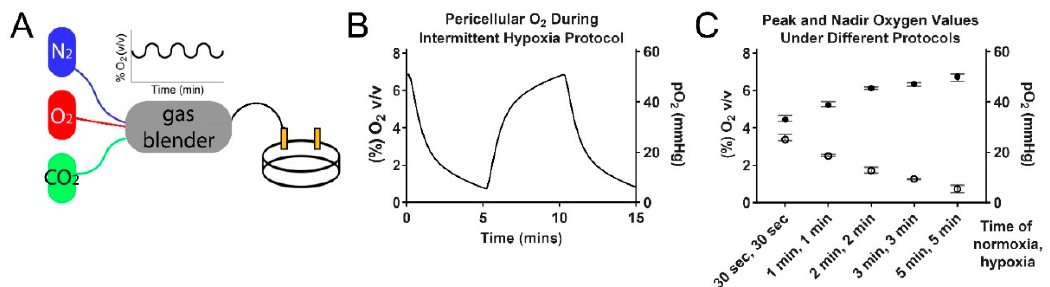
Figure 2. Building a model of OSA-like intermittent hypoxia. ( A ) The model for exposing cells to intermittent hypoxia. A programmable gas blender controls oxygen delivery to a small chamber containing cells grown on oxygen permeable dishes. ( B ) Pericellular oxygen levels during the administered intermittent hypoxia protocol. ( C ) The peak and nadir pericellular oxygen measurements using different lengths of normoxia and hypoxia in the gas phase (normoxia set to 12% oxygen and hypoxia set to 0% oxygen). Average values ± range.